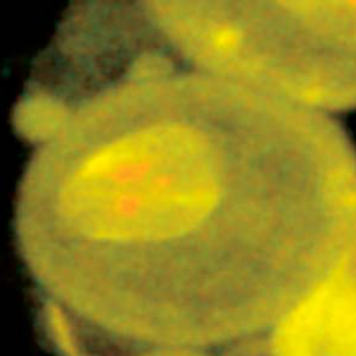
the authors themselves, cannot be ruled out (Church et al.